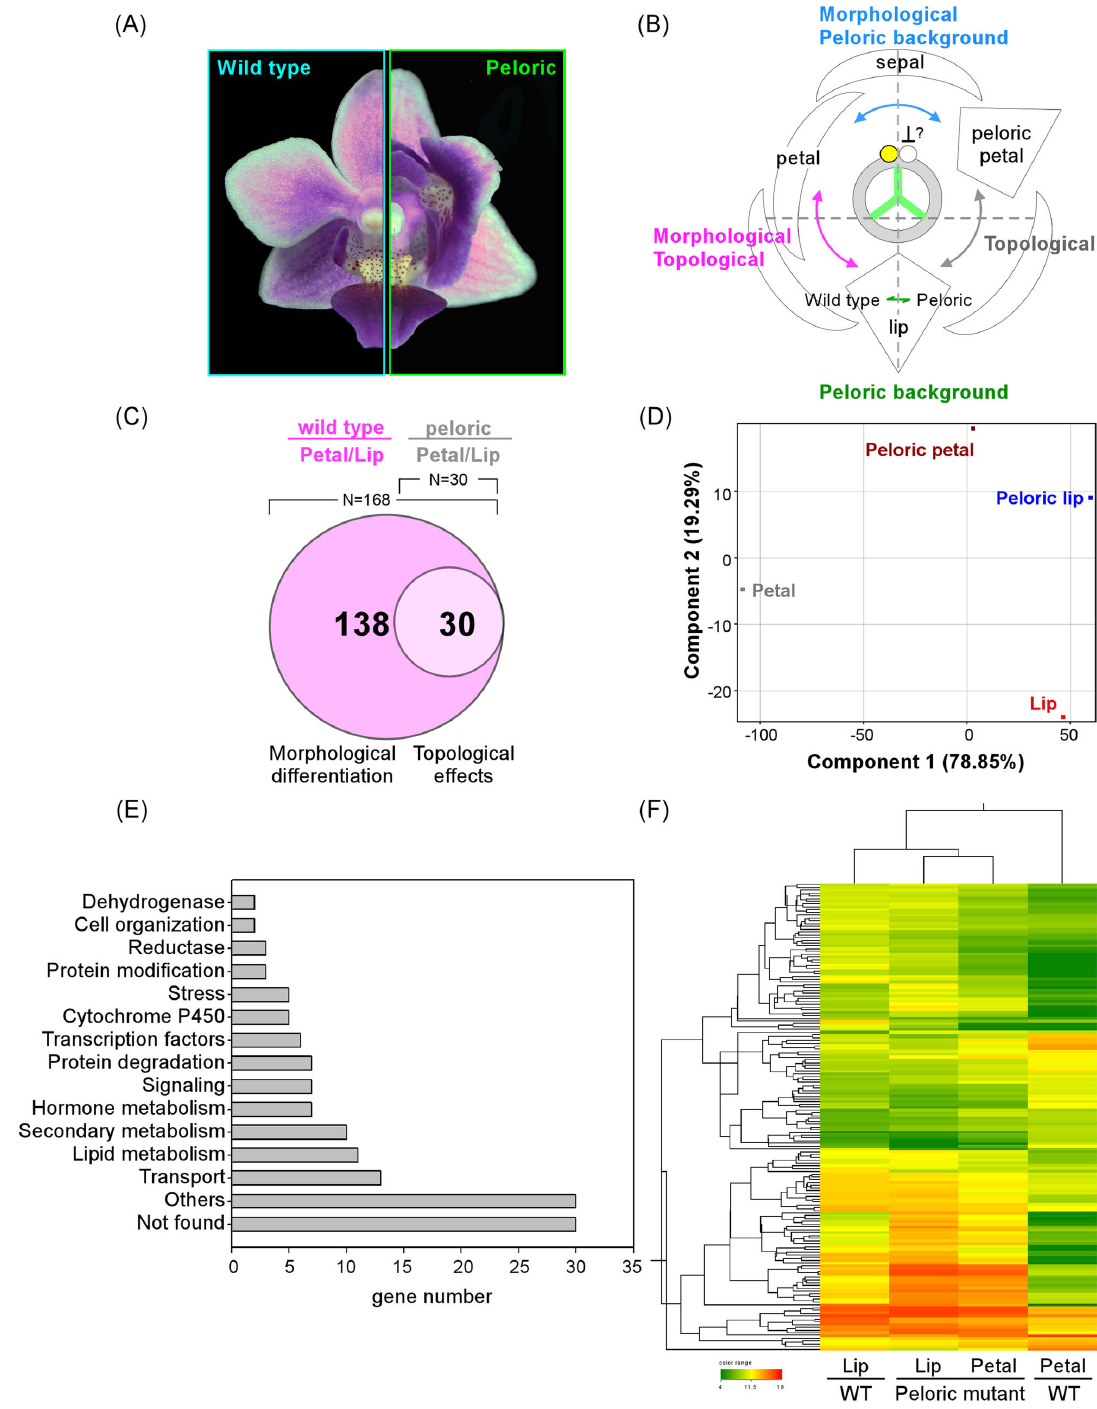
Figure 5. Gene classification from comparative analysis of expression profiles of wild-type and peloric mutants. (A) Phenotypes of wild-type and peloric mutants of Phalaenopsis equestris . (B) Proposed model of mechanism of peloric formation. (C) Venn diagram of genes differentially expressed in petal and lip tissues of either wild-type or peloric mutant (difference > 4-fold). (D) Principal component analysis (PCA) of genes shown in C that are differentially expressed in petal or lip tissues. (E) MapMan analysis of gene categories from PCA analysis (absolute value of loading score > 0.8) in D. (F) Genes clustering analysis of 168 genes in C that are differentially expressed in petal and lip tissues. doi: 10.1371/journal.pone.0080462.g005 PLOS ONE |